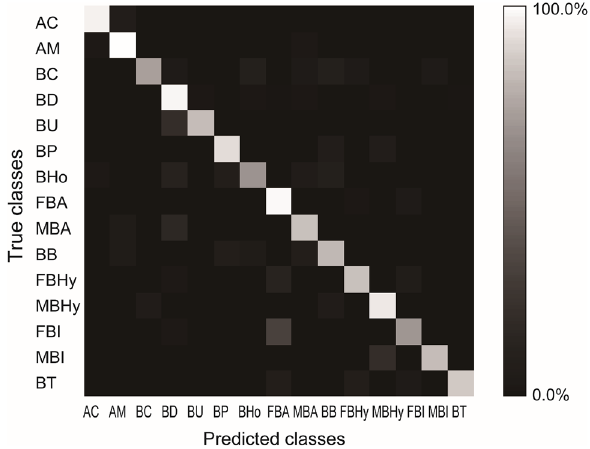
Figure 4. Confusion matrix in color class experiment by Xception. Bright color indicates high percentage. AC: Apis cerana , AM: A. mellifera , BC: Bombus consobrinus , BD: B. diversus , BU: B. ussurensis , BP: B. pseudobaicalensis and B. deuteronymus , BHo: B. honshuensis , BA: B. ardens , BB: B. beaticola , BHy: B. hypocrita , BI: B. ignitus , and BT: B. terrestris . F and M in front of them mean female and male,